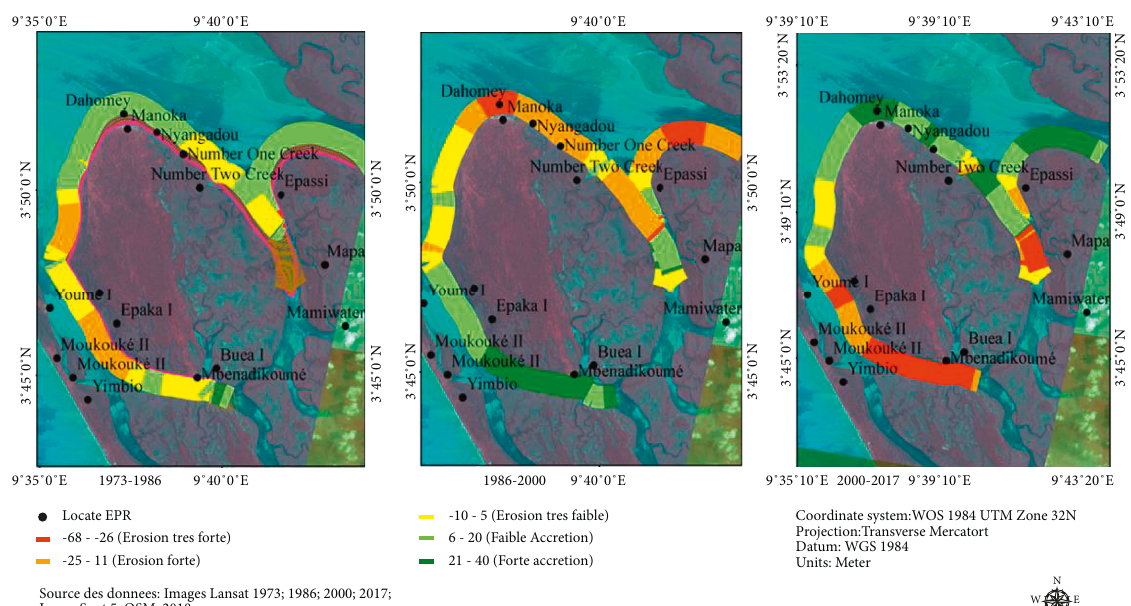
Figure 5: EPR erosion model around Manoka